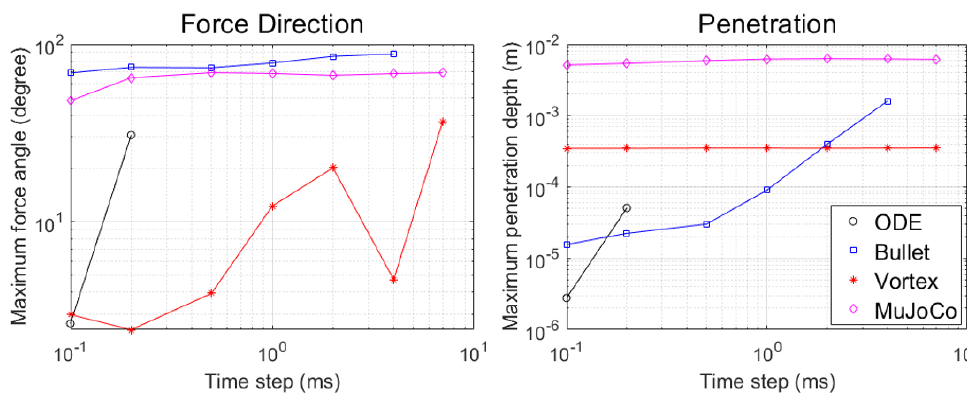
Figure 6. Performance of each physics engine for multipoint contact scenario: ( left ) maximal angle of the friction force acting on the cylinder; ( right ) maximal penetration depth of the cylinder.